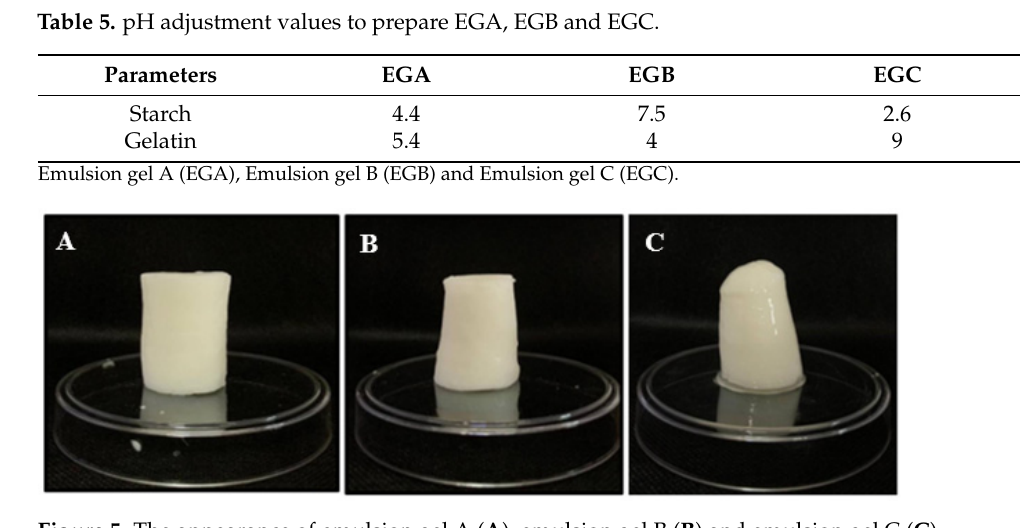
Figure 5. The appearance of emulsion gel A ( A ), emulsion gel B ( B ) and emulsion gel C ( C